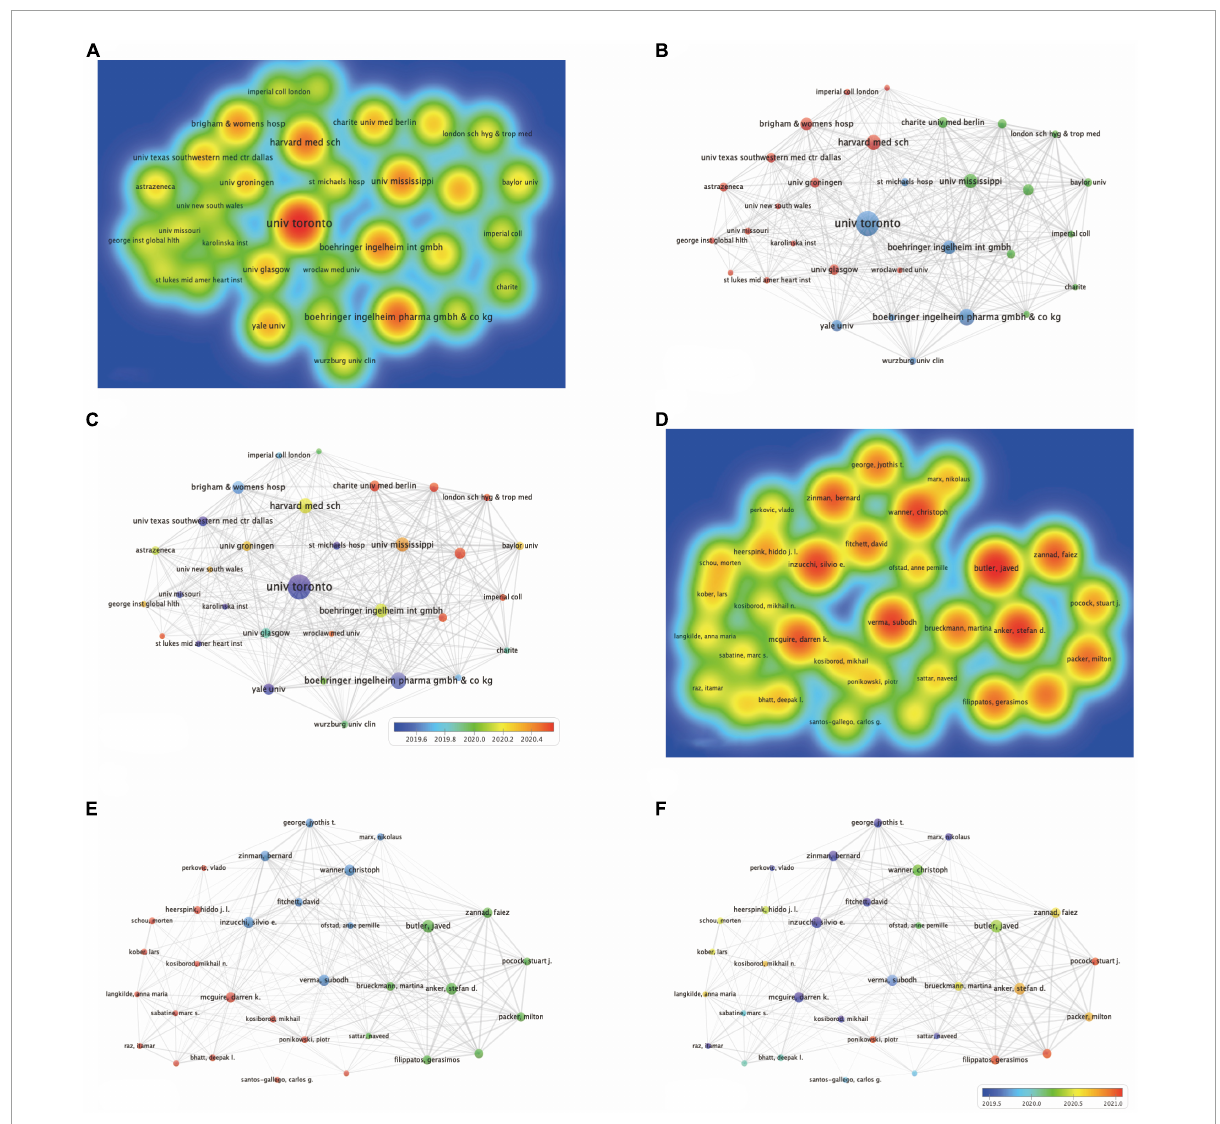
FIGURE3 The analysis of institutions and authors. (A) The destiny of all contributing institutions. (B) The occurrence of all contributing institutions. (C) The time overlay of all contributing institutions. (D) The destiny of all contributing authors. (E) The occurrence of all contributing authors. (F) The time overlay of all contributing